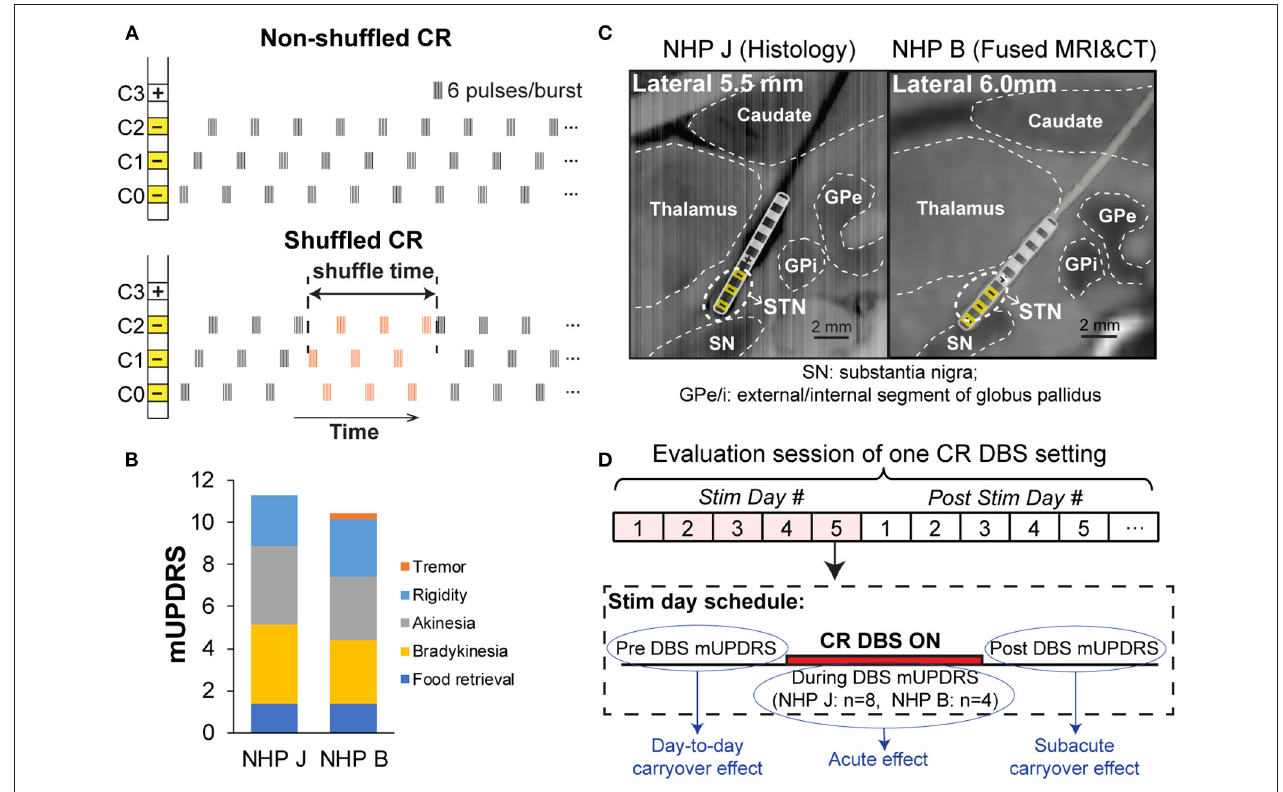
FIGURE 1 | (A) Non-shuffled and shuffled coordinated reset deep brain stimulation (CR DBS) patterns. Top: Non-shuffled CR DBS repeats the order of delivering bursts to different contacts, i.e., same contact sequence, throughout the stimulation time. Bottom: Shuffled CR pseudo-randomly changes the contact sequence at a certain frequency. (B) Mean total and subscores of modified Unified Parkinson’s Disease Rating Scale (mUPDRS) for two Parkinsonian monkeys. (C) Deep brain stimulation (DBS) lead locations. Left: Sagittal view of the DBS lead track reconstructed from histology in NHP J (C0-C7 from bottom to top contact); Right: Fused MRI/CT images showing the DBS lead location. The lead schematic was overlaid in each figure and the stimulation contacts for CR DBS are indicated (yellow). (D) The experiment timeline demonstrates the evaluation schedule of CR DBS, and the mUPDRS scores used to assess the acute, subacute carryover, and day-to-day carryover